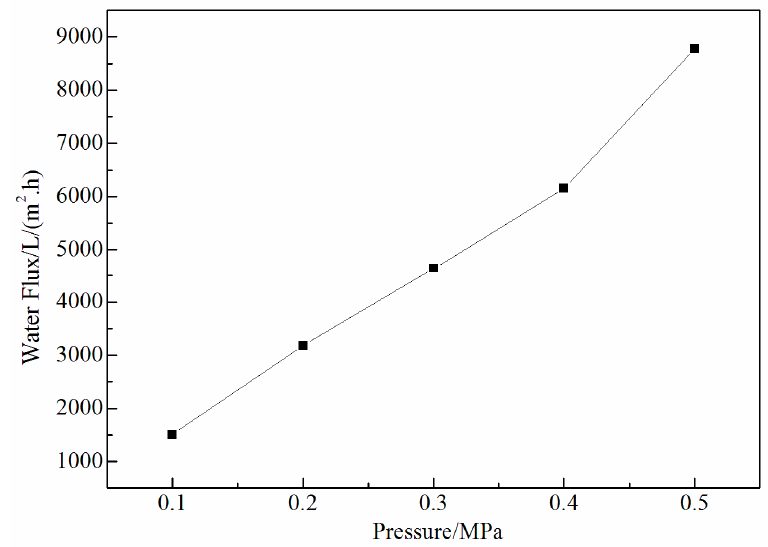
Figure 9. Water-permeating flux of the ceramic membrane.